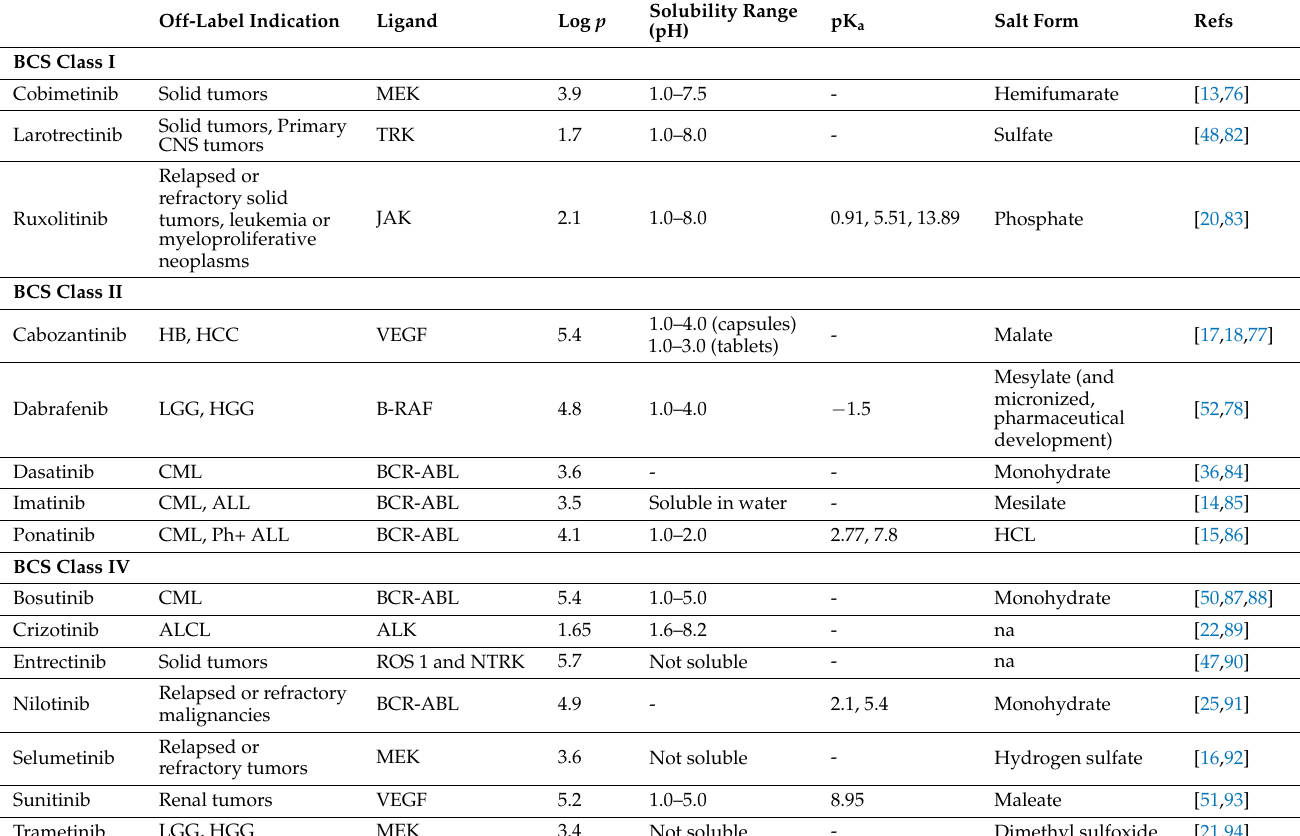
Table 2. Physicochemical properties and pharmacological characteristics of